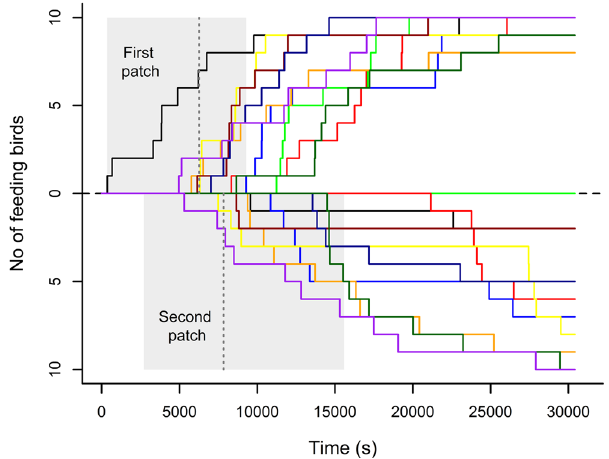
Figure 1. Diffusion curves showing the latency of individuals to feed from the two hidden food patches in the flocks. Each coloured line represents one flock, and the same colour denotes the same flock at the first-exploited patch (upper half of the panel) and the second-exploited patch (lower half of the panel). Time to first approach is indicated by a grey bar at each patch, with the dashed lines showing the mean